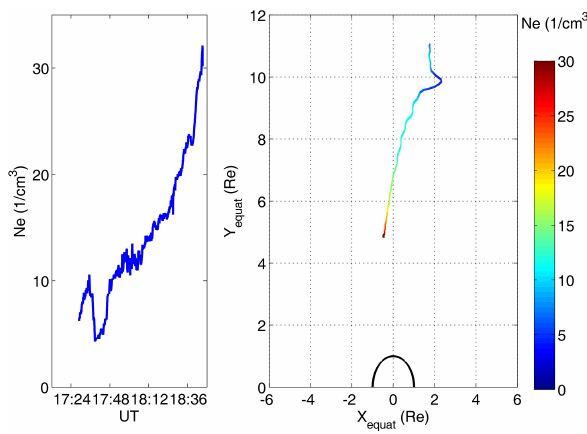
Figure 3. Electron density observed by the WHISPER instrument of C3 during between 17:12 and 18:48UT on 3 June 2004. Left panel: electron density vs. UT. Right panel: electron density plotted along the trajectories of C3 projected along the magnetic field lines onto the equatorial plane in a co-rotating geocentric solar magneto- spheric (GSM) frame of